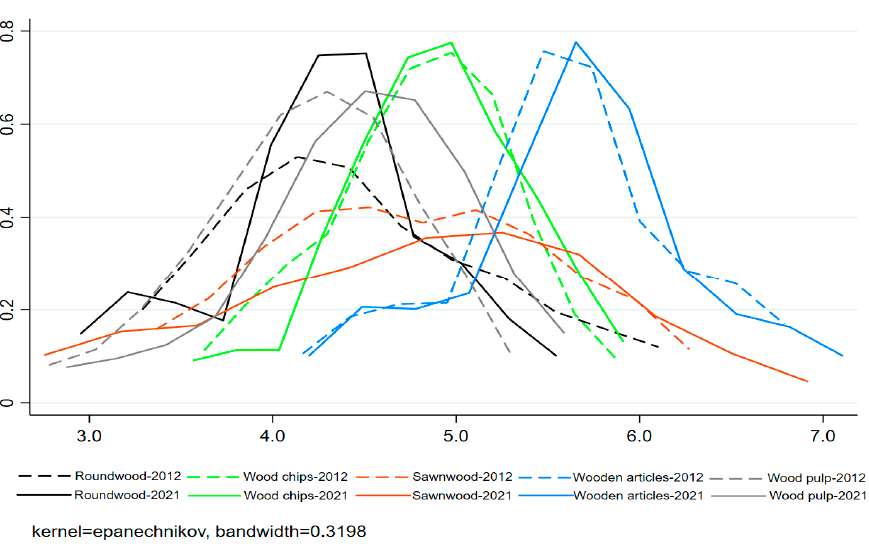
Figure 4. Kernel density map of the international competitiveness of other paper products in the countries observed.